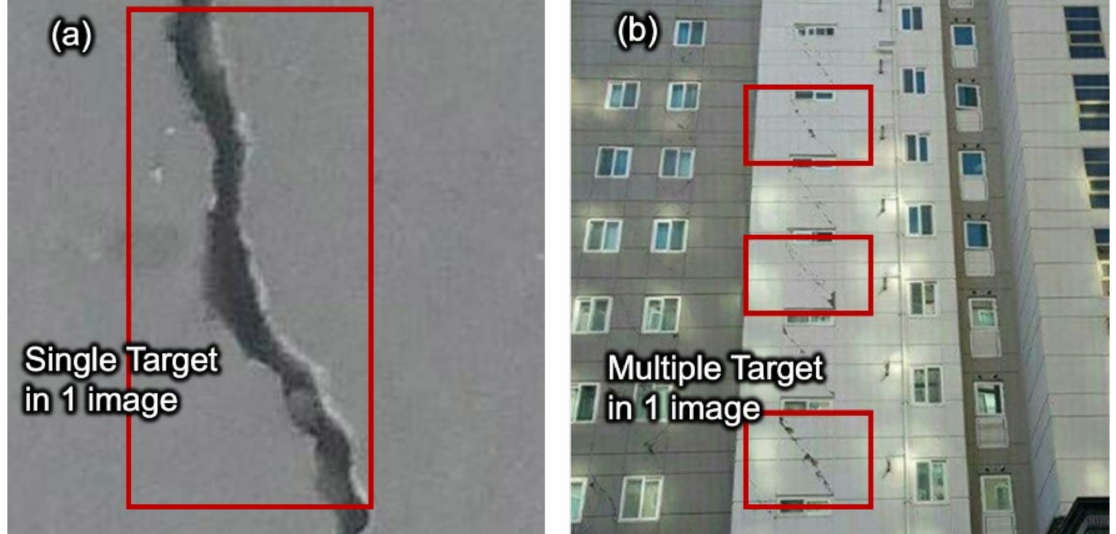
Figure 3. Difference between ( a ) an example of learning data collected in the era when image classification techniques were dominant and ( b ) learning data collected after object detection was developed. ( a ) Data can also be used for object detection, but they are less efficient and may lead to inaccurate